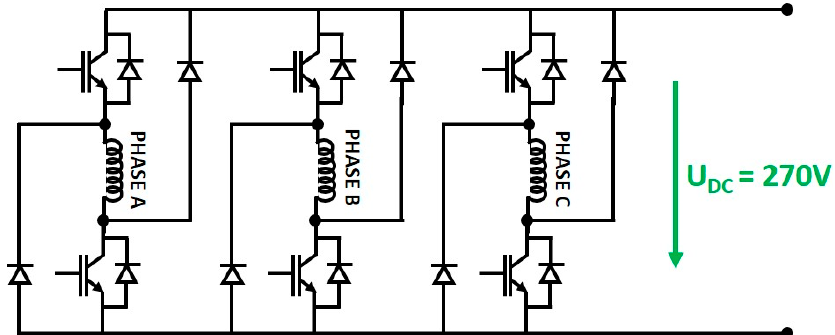
Figure 9. 3 H-bridge machine-side power converter.